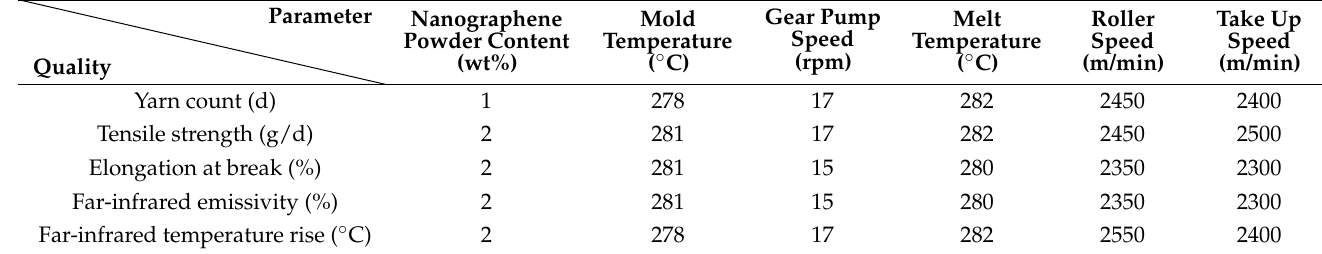
Table 25. The single quality optimization parameter combination.